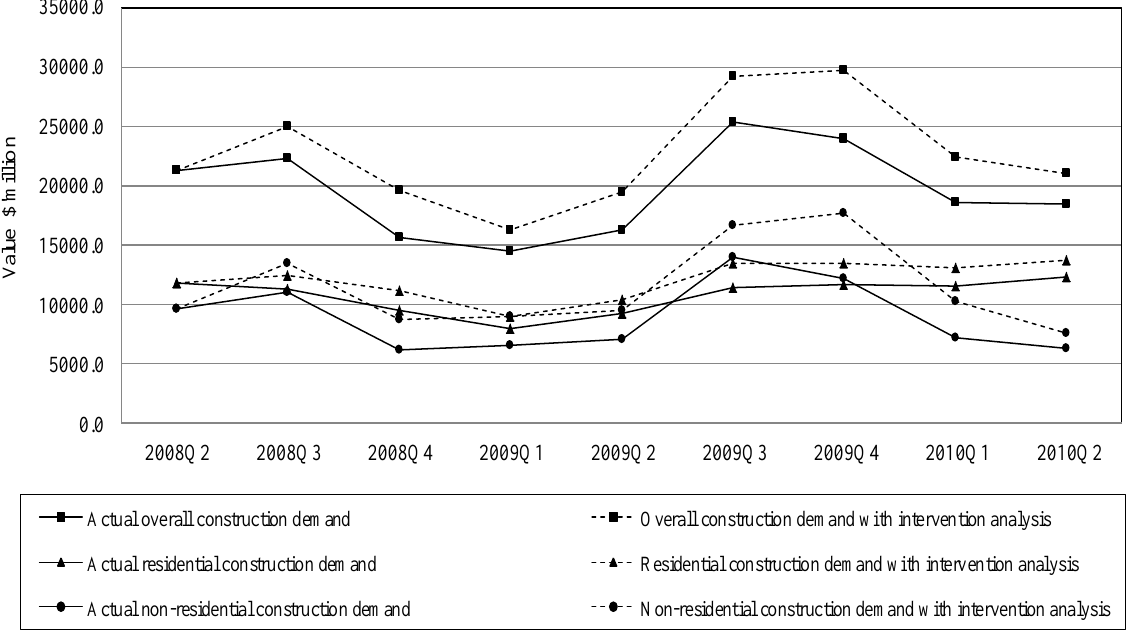
Figure 3 Comparison of different types of actual construction demand and construction demand with intervention analysis during the crisis (Scenario